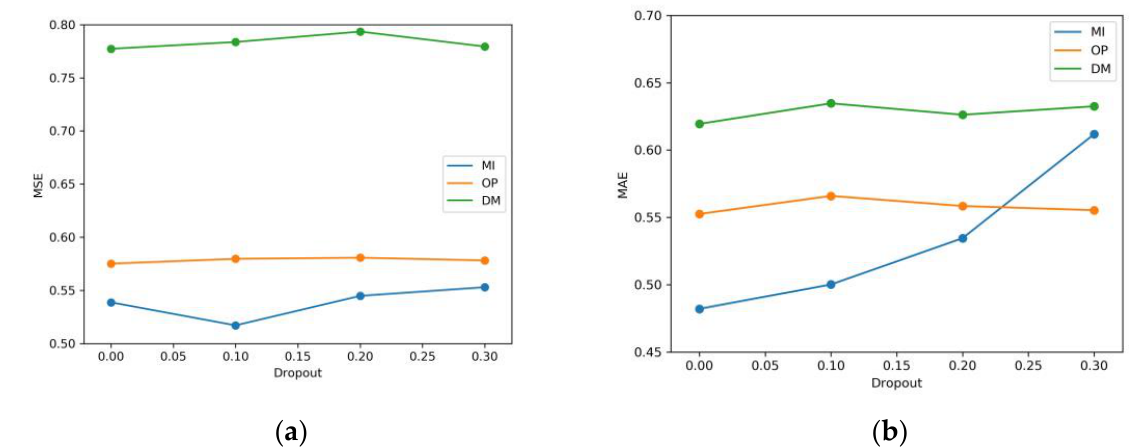
Figure 5. Performance of the different dropouts of the RSII model. ( a ) The MSE of different dropouts; ( b ) The MAE of different dropouts.